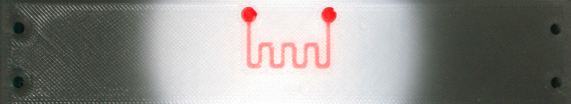
Figure 6. Layout of the 3D printed substrate with embedded microfluidic channel filled with coloured fluid.